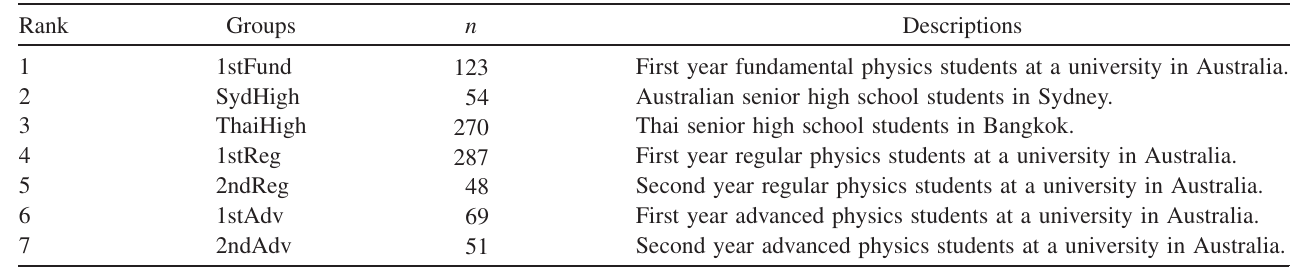
TABLE II. Summary of